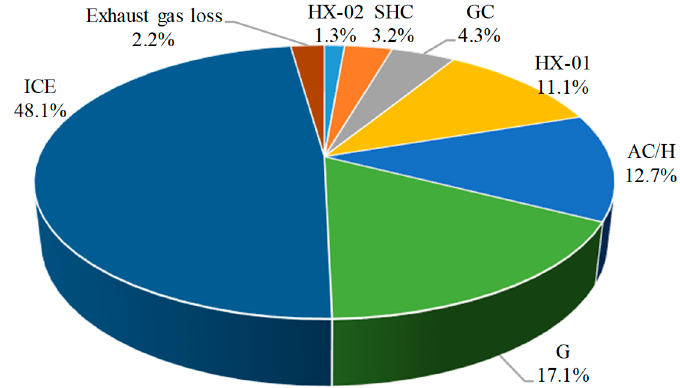
Figure 3. Average exergy destruction and loss of components in the two operation modes.